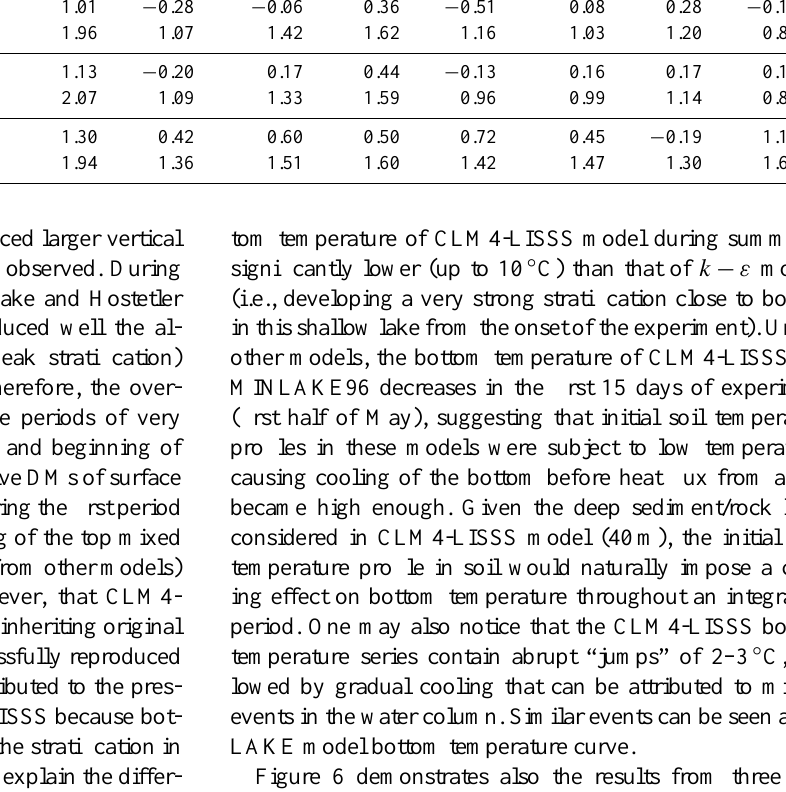
Table 4. The surface temperature errors ( ◦ C) in model experiments when using different lake depths ( h ). FLake Hostetler LAKE whole 2 whole whole period period 1 period 2 period period 1 period 2 period period 1 period 2 h = 1 . 2m (local depth DM 0.39 1.01 −